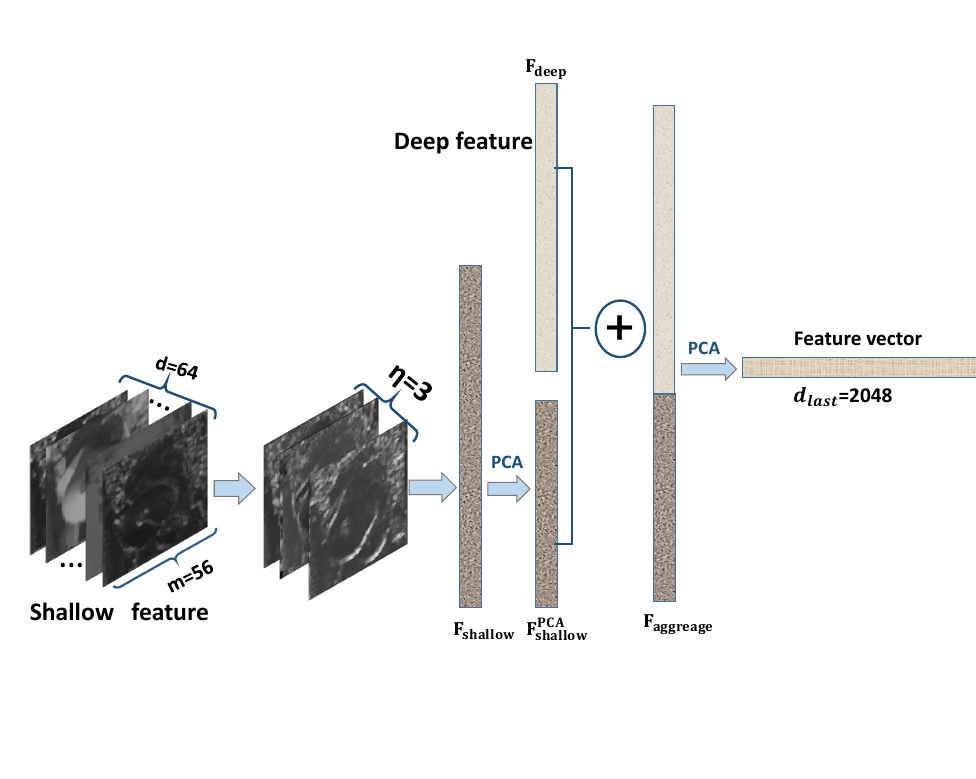
Figure 2. Deep perception